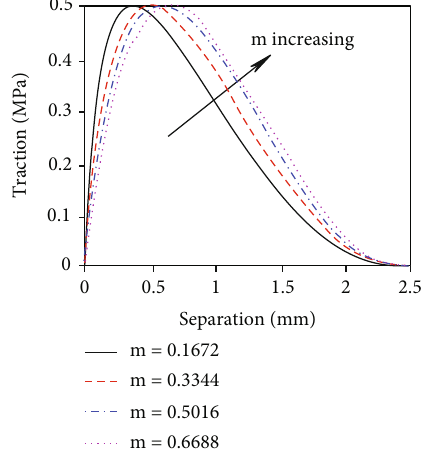
Figure 6: Response under di ff erent transition parameter m , σ